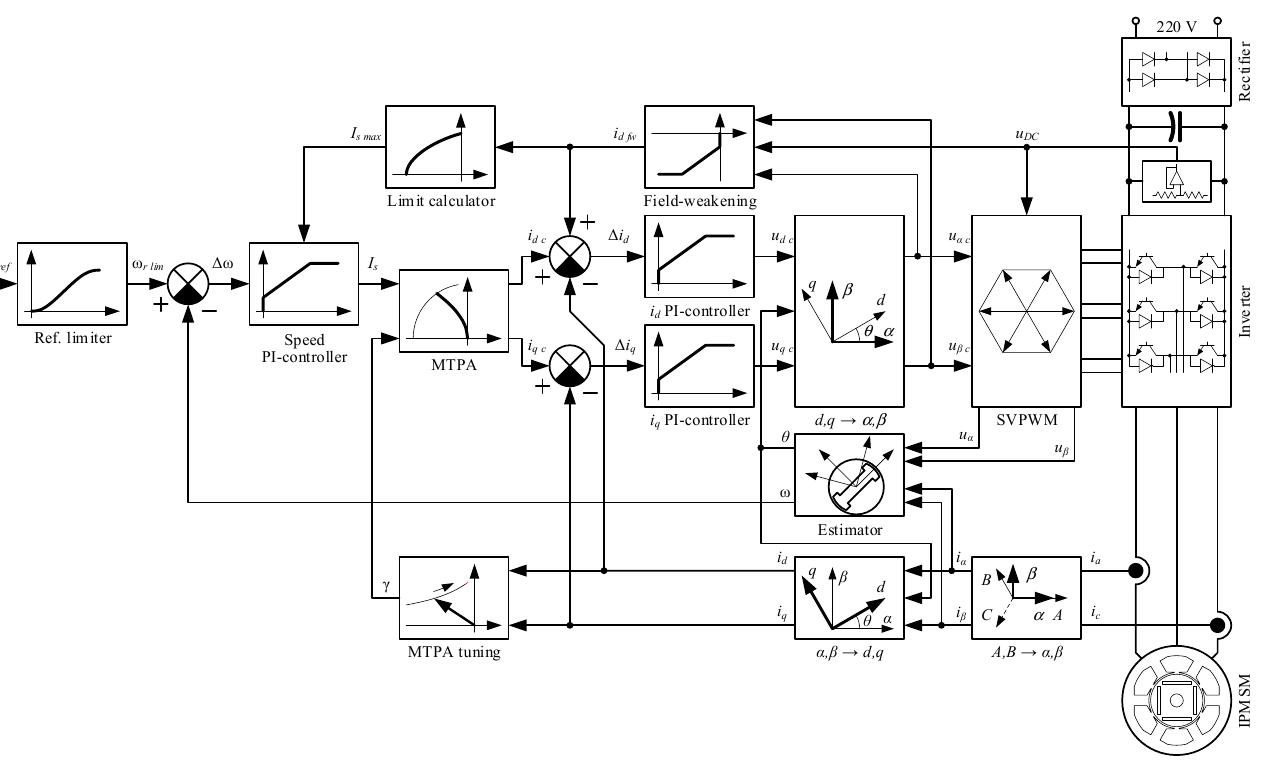
Figure 13. Control block diagram of the IPM motor drive with seeking MTPA algorithm.